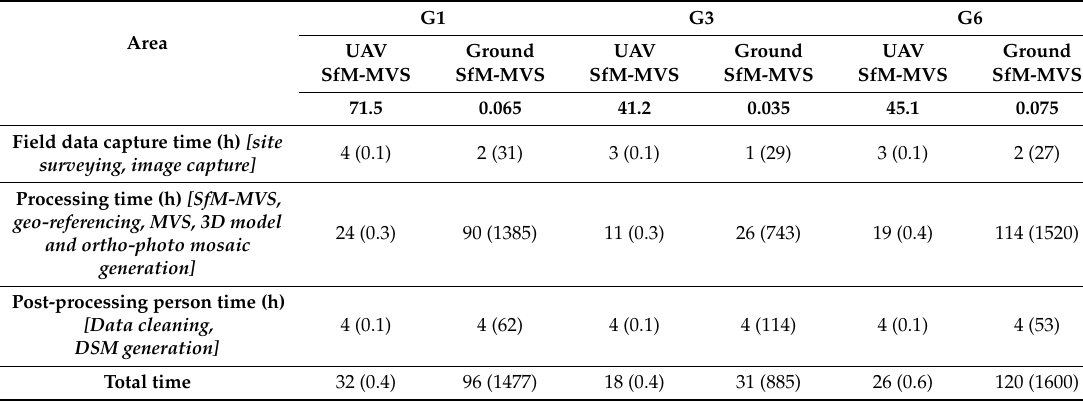
Table 6. Comparison of approximate * time requirements to deliver topographic models presented in this study. Numbers in brackets represent normalised values per